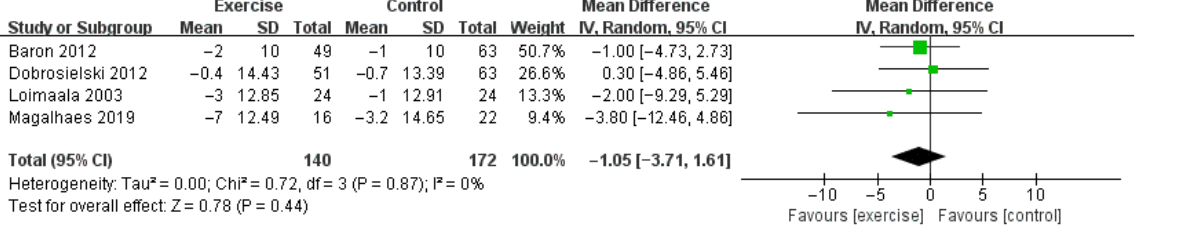
Figure 5. The pooled result of the difference of changes in systolic blood pressure between two groups [35–38].